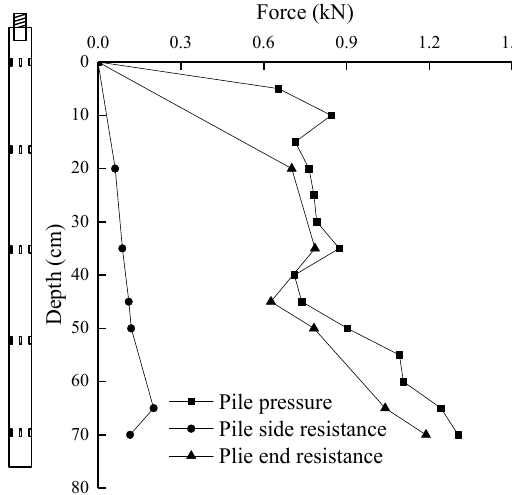
Figure 12. Pile driving force with penetration depth curve.